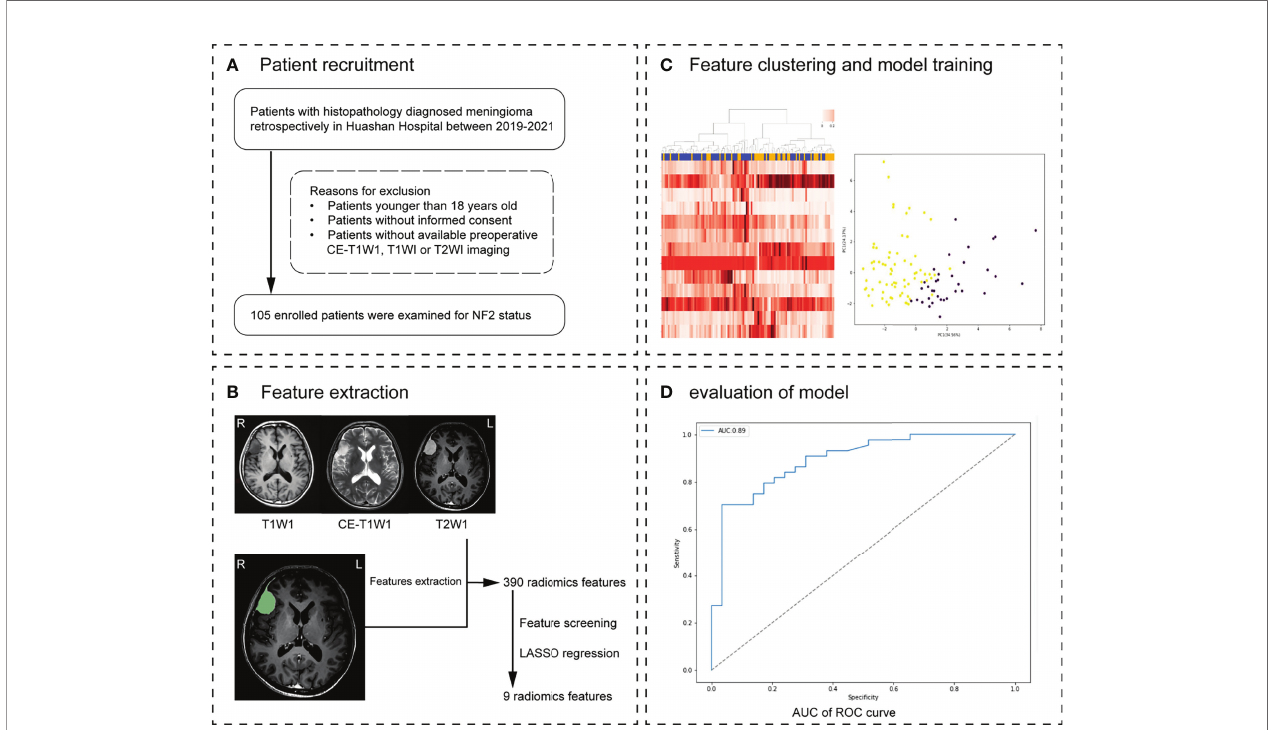
FIGURE 1 | Work fl ow. (A) Patient recruitment strategy. (B) 390 features were extracted from region of interest (ROI) on each magnetic resonance imaging (MRI) sequence. (C) The inner loop included hyperparameter tuning and features selection in the training datasets. After feature selection, the model with optimal parameters was used for prediction in the test set. This procedure developed 10 different models with speci fi c sets of features and hyperparameters. (D) The effectiveness of the model was veri fi ed in the validation group. Receiver operating characteristic (ROC) analysis and precision and recall (P-R) analysis were used for model performance evaluation. The MRI scans of 30 meningioma patients from another hospital were used as external